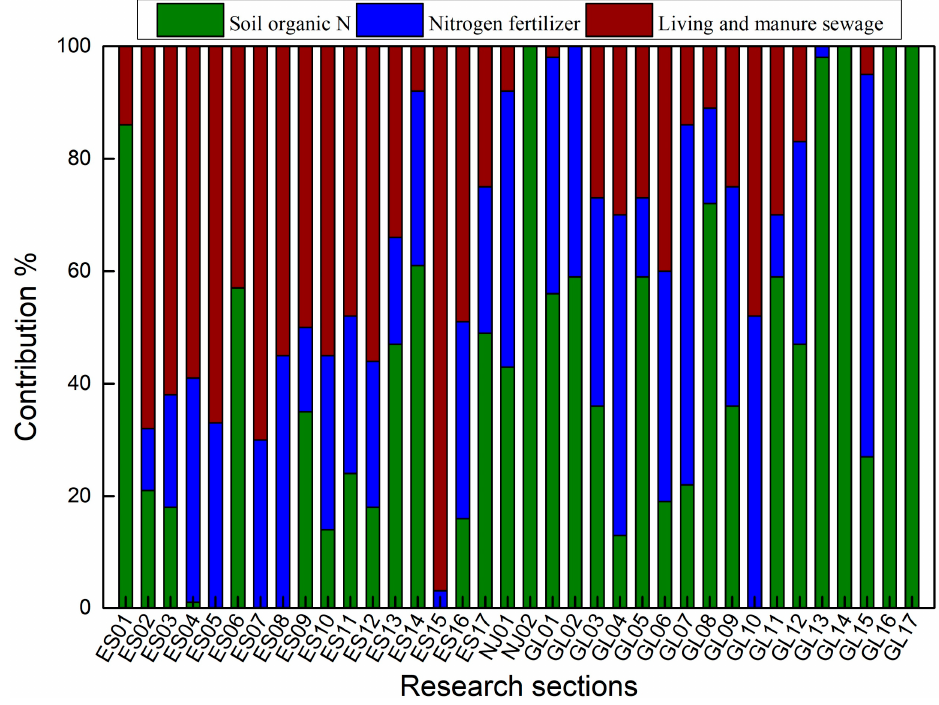
Figure 5. The contribution rate of nitrogen in the SHR during high flow season.